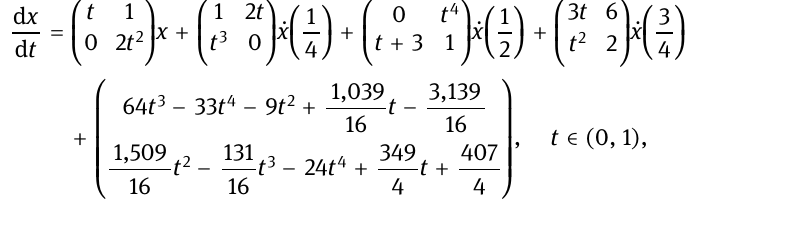
Table 1: Error analysis in Example 1 ( using the fourth - order Runge - Kutta method